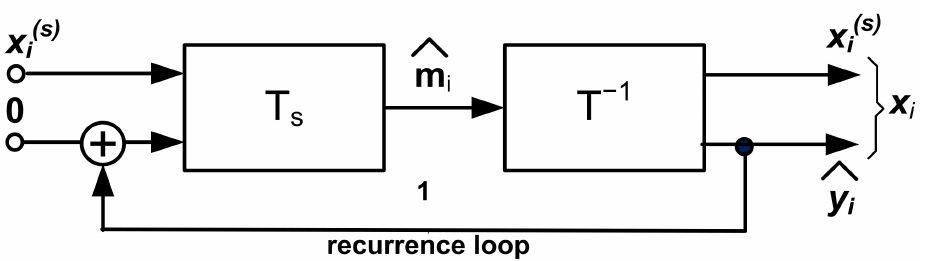
Figure 7. Structure of the reconstruction system when a fragment of the image (k–lines) is kept as the